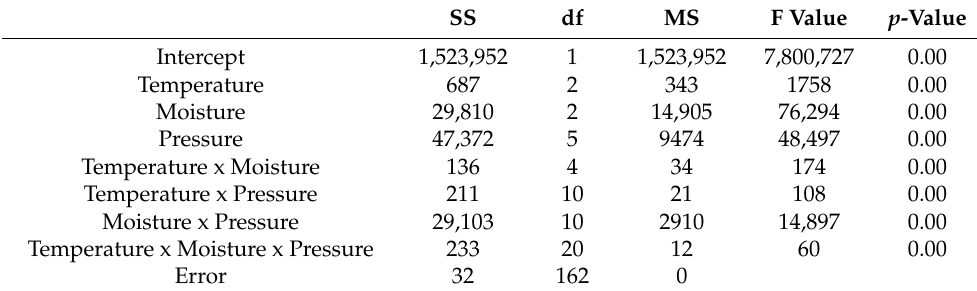
Table 2. Three-way analysis of variance ANOVA—DU.